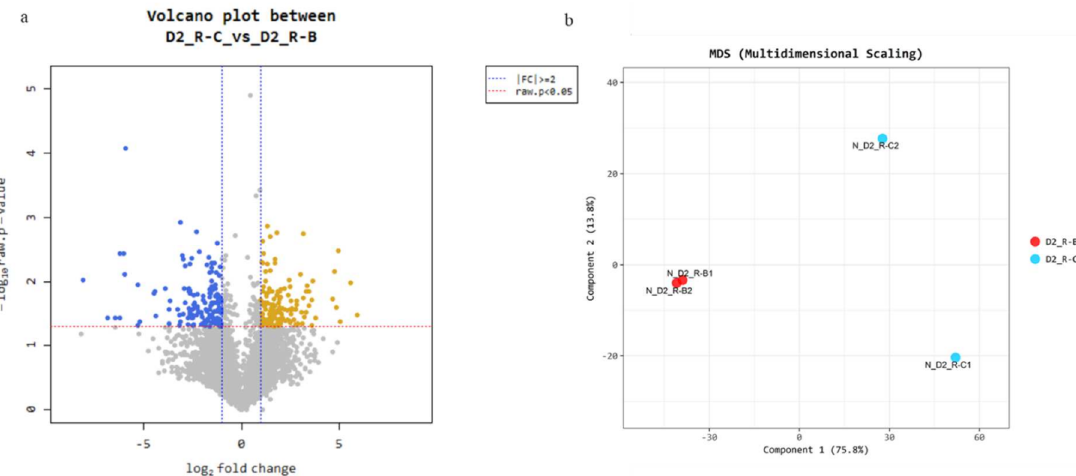
Figure 4. ( a ) Scatter plot shows expression levels between comparison pairs as a scatter plot. The X —axis is control and Y —axis is the average normalized value of the DEGs group. The colored dot by volume which satisfies the |fc| ≥ 2 and independent t -test raw p -value < 0.05. ( b ) Multidimensional scaling comparison between control and